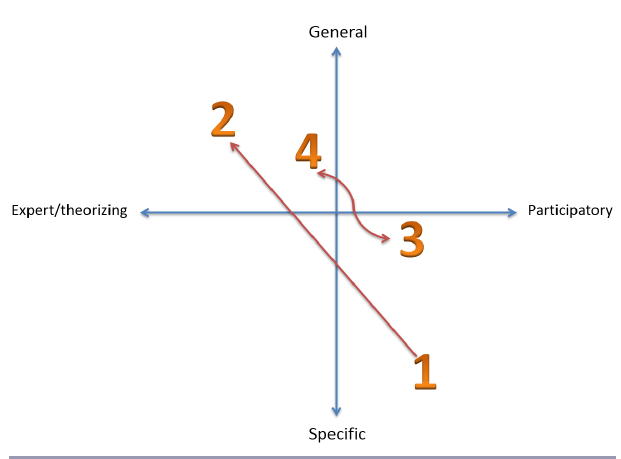
Fig. 4 . Weathers’s research